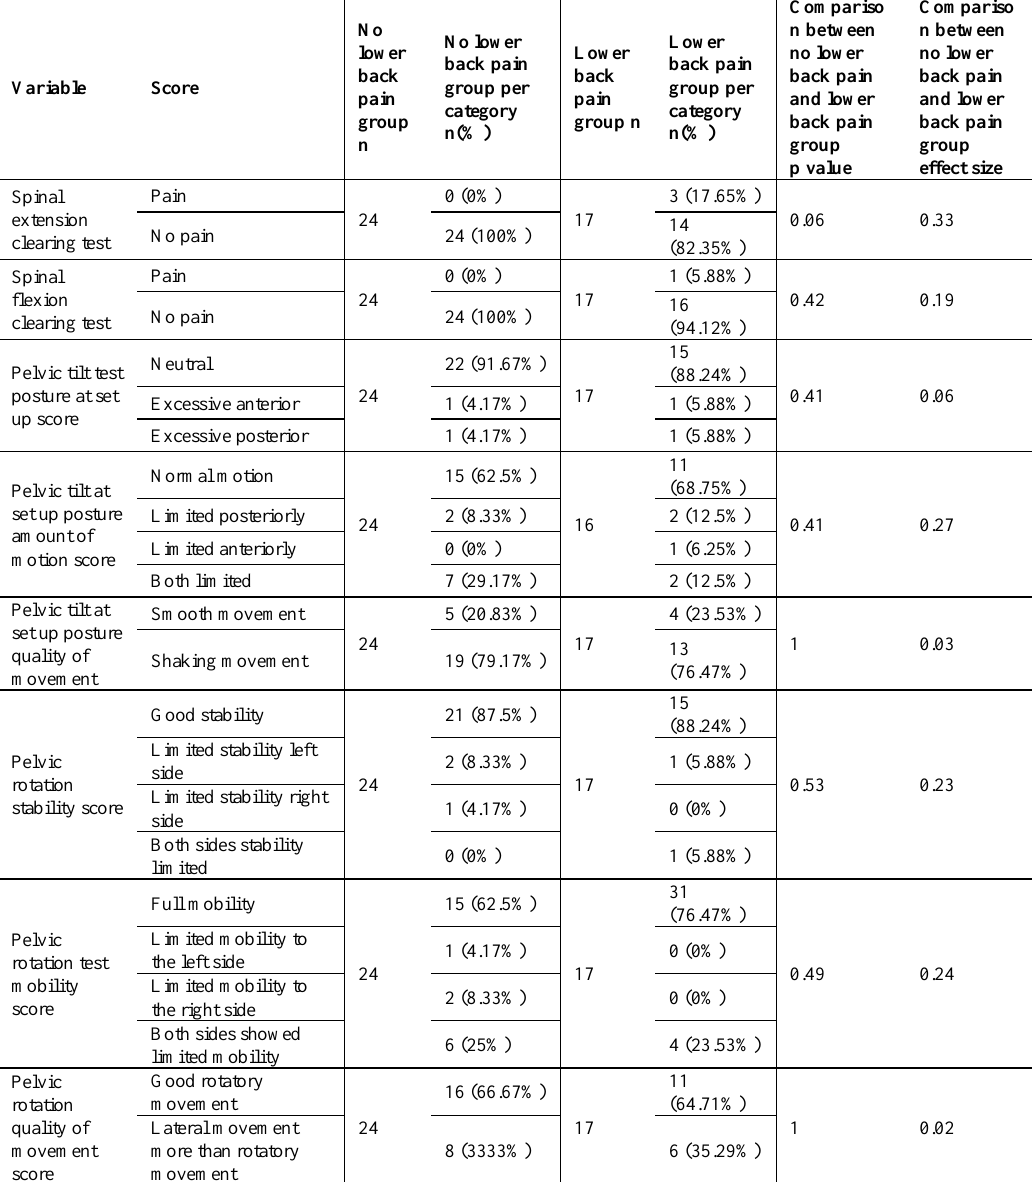
Page 1 of 4: Table comparing categorical screening test results for those with lower back pain compared to those without lower back